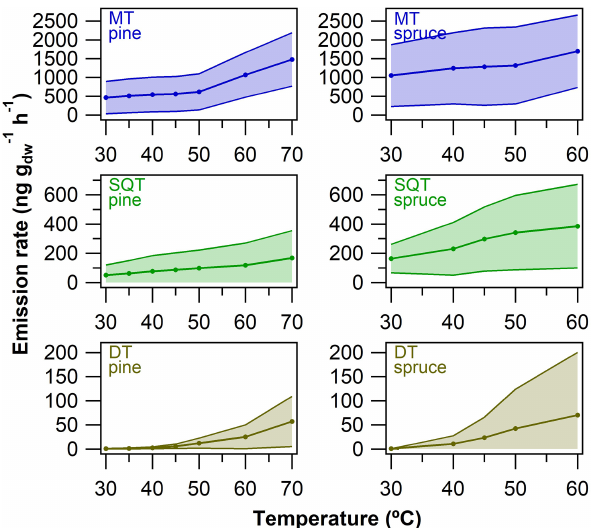
Figure 8. Terpenoid semi-quantitative emission rates from pine nee- dles and spruce twigs as a function of oven temperature in the dy- namic headspace extraction experiments. The average ( ± standard deviation) emission rates of MTs, SQTs and DTs were calculated based on data presented in Figs.